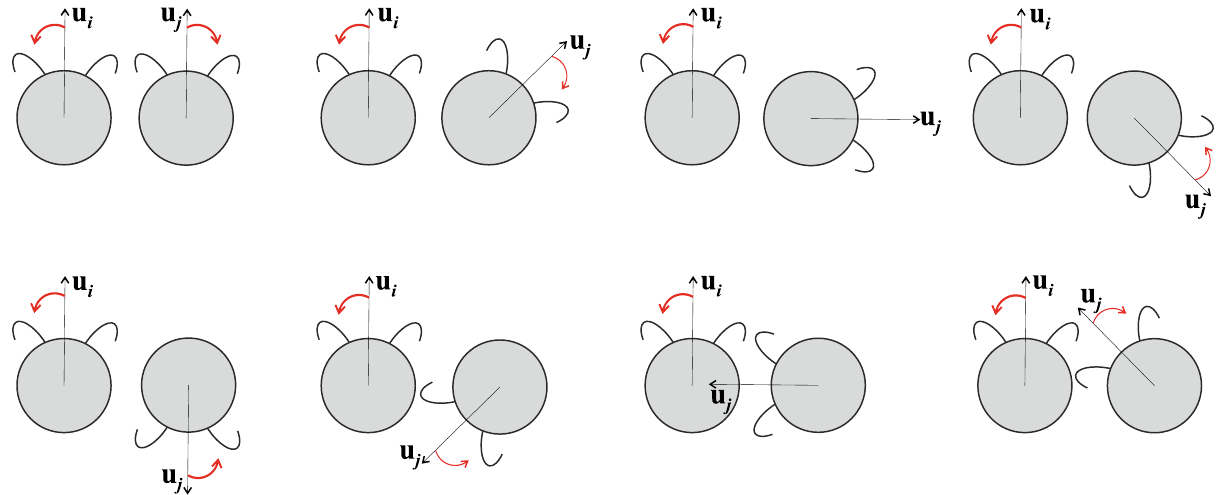
Figure 1. A schematic of the encounter between two Chlamydomonas . Their current unit orientation vectors u i are depicted in light black, while their directions of rotation upon interactions modeled by non-reciprocal torques from Eq. (5) are displayed in red. As an illustration eight different examples are shown. The torques are non-reciprocal in the general case (hinted by different thicknesses of the red